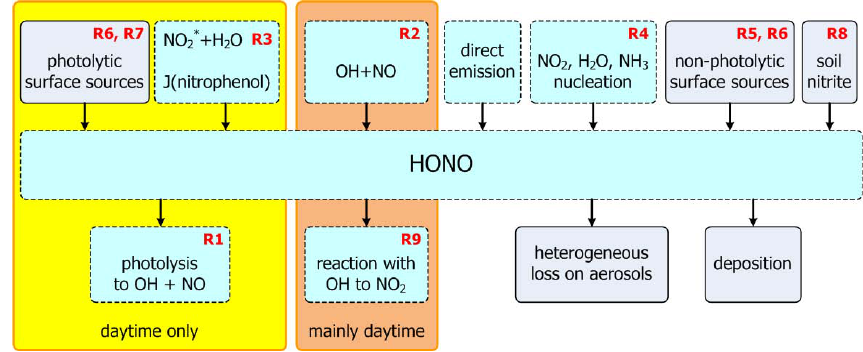
Fig. 1. Diagram of HONO budget in the troposphere. Boxes in light blue refers to gas phase reactions, while grey boxes refer to processes with various surfaces involved. Reactions in the yellow frame need solar radiation and thus only take place in daytime. When significant amount of OH radicals and NO exist, reactions in the light orange frame will also happen in